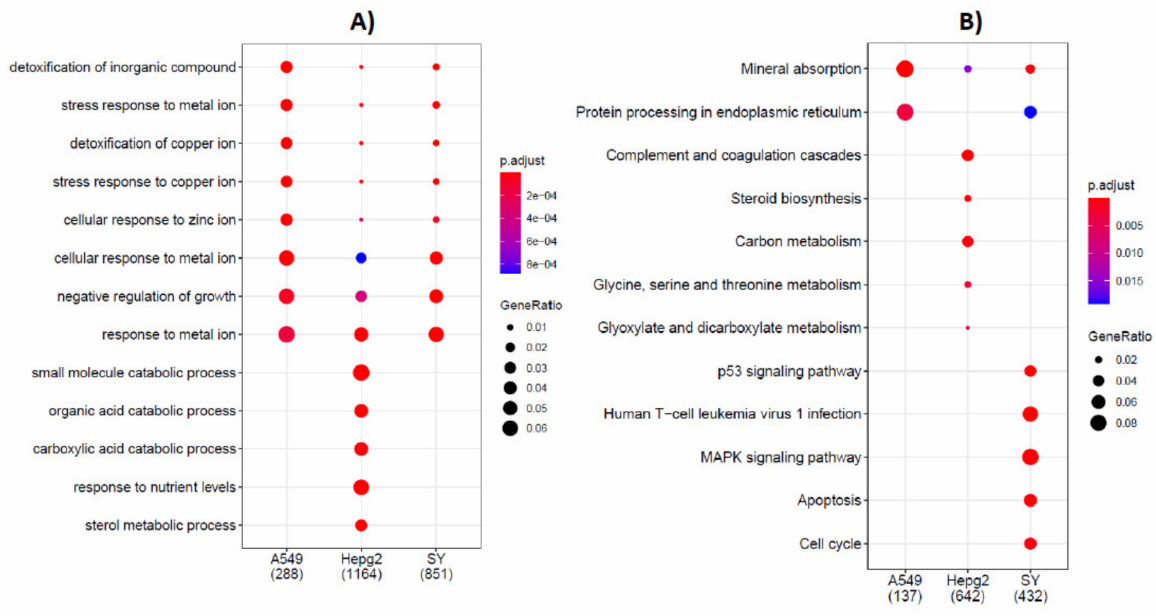
Figure 2. GO term and KEGG pathway enrichment analysis for DEGs after Cd treatment in human pulmonary (A549), hepatic (HepG2) and neuronal (SH-SY5Y) cells. ( A ) GO enrichment analysis. ( B ) KEGG pathway enrichment analysis. The number of DEGs in the three cell models is indicated in parenthesis. ClusterProfiler package was